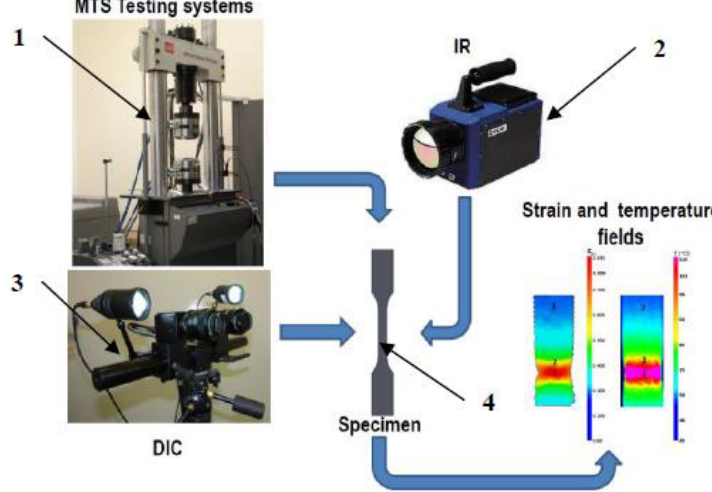
Figure 4. Test stand: 1 — Fatigue testing machine, 2 — thermal imaging camera IR, 3 — Aramis video system DIC (Digital Image Correlation), 4 — test sample.